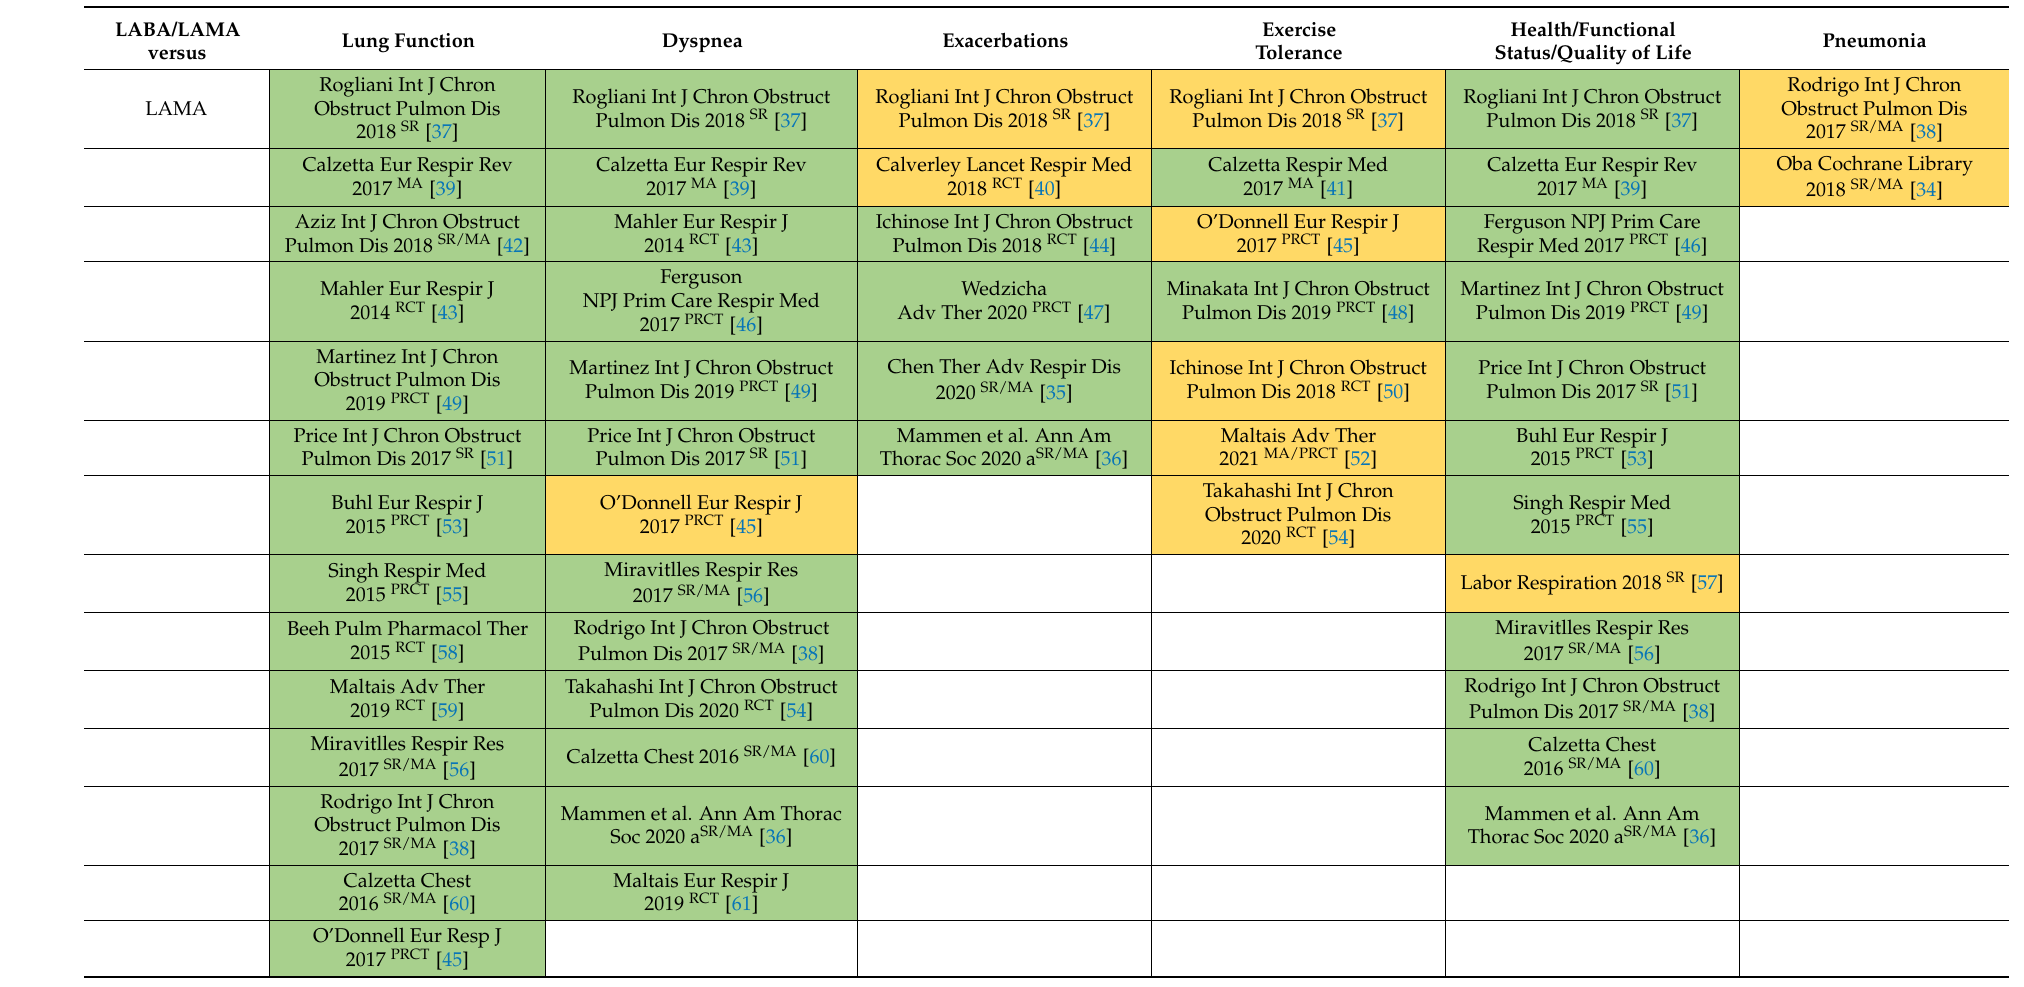
Table 3. Comparison of LABA/LAMA with monotherapy, LABA/ICS or triple